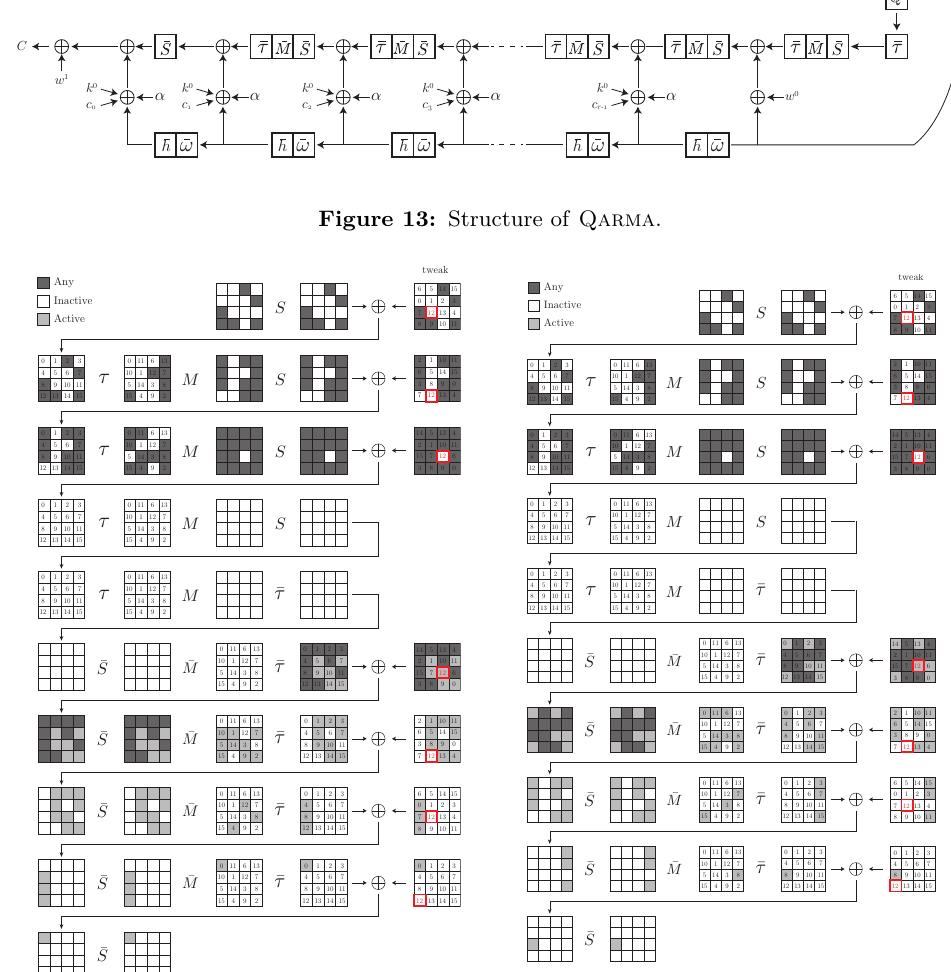
Figure 14: Two zero-correlation linear hulls on Qarma 4 , 5